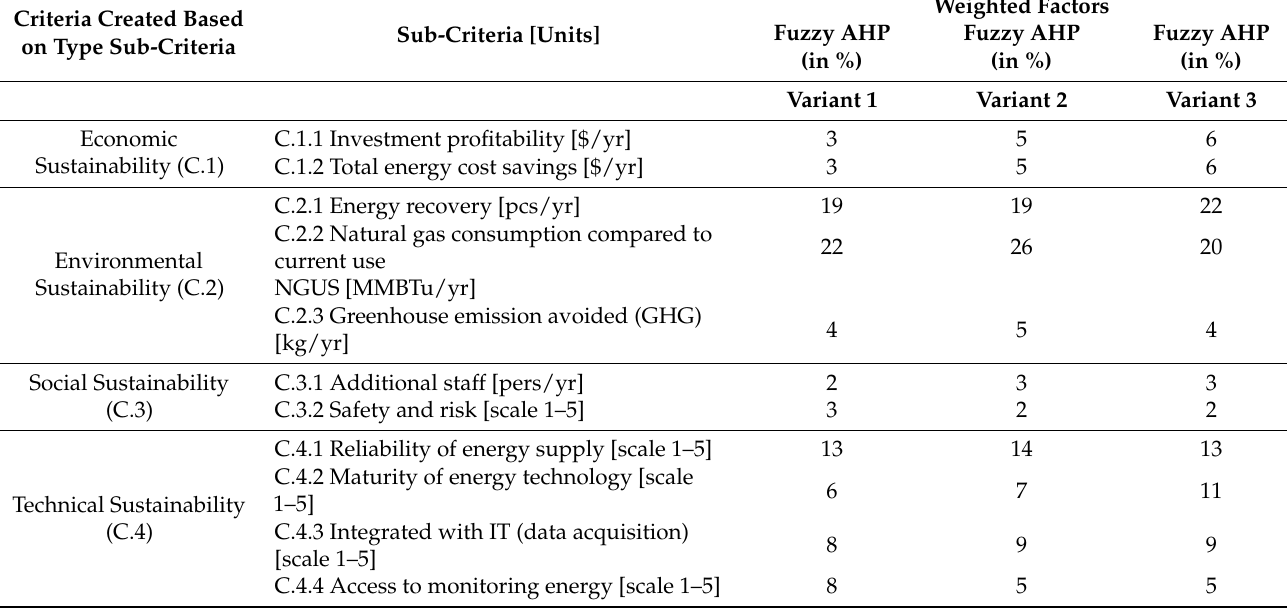
Table 7. Evaluation of technology by ranging the grouped sub-criteria using fuzzy AHP methods–evaluation scores for sub-criteria under energy technology